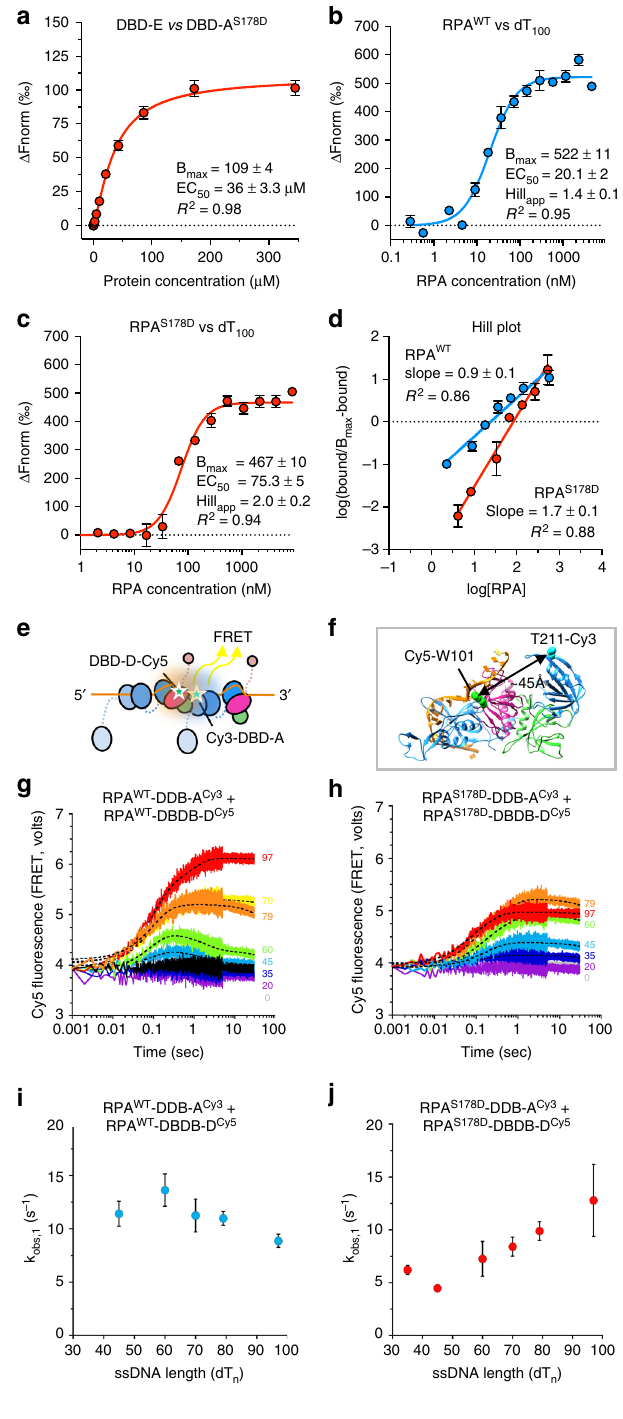
the Tri-C that we assign as DBD-B. Multiple reconstructions from subclasses show that this domain possesses signi fi cant fl exibility precluding its accurate reconstruction. However, the location of this domain is signi fi cantly different from the location of DBD-B (and thus DBD-A) in the crystal structure of the 30-nt compact mode 13 , suggesting an alternative, extended, path for ssDNA. Models proposed by others 39 , show that the DBD-A and/or DBD-B tandem binds to ssDNA in a more dynamic manner than previously thought, and our data suggest that these domains are stabilized when braced by another RPA on ssDNA as part of RPA – RPA interactions (see below). FRET-based ana- lyses using labeled ssDNA to assess the con fi guration of the oligonucleotide when bound with RPA suggests that ssDNA is linearly arranged when bound by multiple ScRPA and that the extension is likely to be uniform within each ScRPA and between adjacent ScRPA molecules. What is more, even using a short dT 30 oligonucleotide capable of binding a single heterotrimer still shows a reduction in FRET, indicative of a linear conformation of ssDNA, as a result of stoichiometric binding of RPA, suggesting that the linear arrangement of ssDNA within RPA is the domi- nant con fi guration although we do not rule out the existence of the compact horse-shoe conformation observed in the crystal structure. Our cryoEM model of two RPA complexes in close proximity on ssDNA indicates an RPA – RPA association and predicts that RPAs can contact one another via DBD-A of one RPA and DBD- E of the adjacent RPA. Our structures also predict that this interaction could stabilize a conformation that allows a linear path of ssDNA. We validated our hypothesis using a combination of FRET-based assays and protein domain interaction studies. Ensemble stopped- fl ow FRET experiments suggest a close asso- ciation between two RPA molecules on ssDNA that is in line with predicted distances based on the association between DBD-E and DBD-A. Protein interaction experiments using puri fi ed